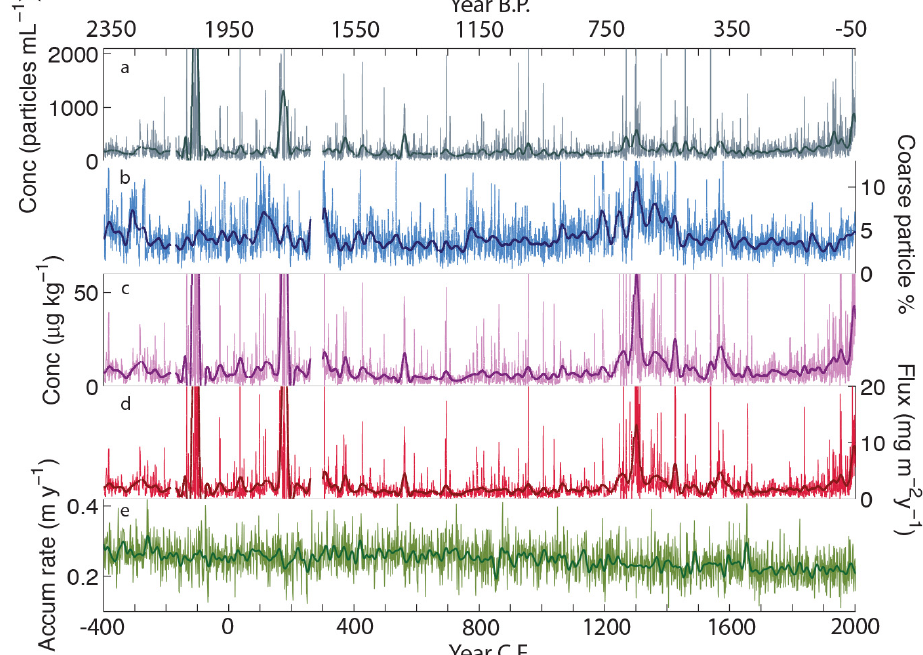
Figure 2. Dust time-series plots: (a) dust number concentration; (b) coarse particle percentage (CPP, defined as number of particlesmL − 1 [4.5–15]/[1–15]µm diameter × 100); (c) dust mass concentration; (d) dust flux; and (e) accumulation rate in meters of water equivalent (from WAIS Divide Project Members, 2013). Thin lines show 1-year filtered data and thick lines show 21-year filtered data, except for (e) , for which the raw data are annual (thin line); in this case the thick line shows the 21-year filtered record.